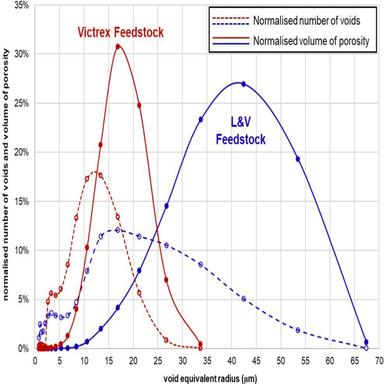
Void size distribution plots for Feedstock filaments; dotted lines display the normalised total number of voids with a given radius, while continuous lines show the normalised volume of porosity that voids with a given radius contribute to.